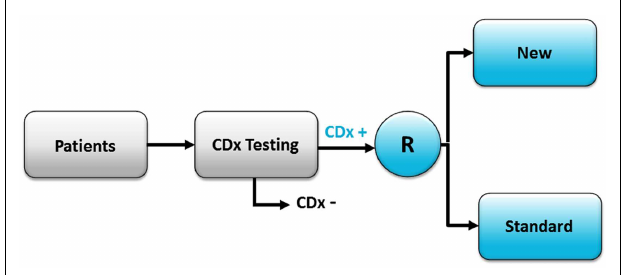
FIGURE 2 |The enrichment clinical trial design .With this design only patients who have a positive CDx assay result are enrolled in the trial and randomized (R) to either the new targeted treatment (New) or standard treatment (Standard). CDx + , indicates test positive patients; CDx − , indicates test negative patients.